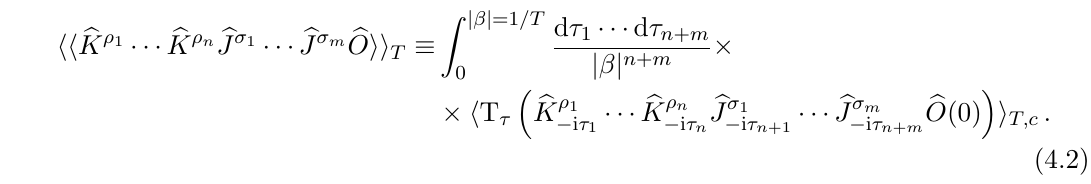
j µ is an (electric) vector current, V K µ and J µ are the Lorentz generators, b b b